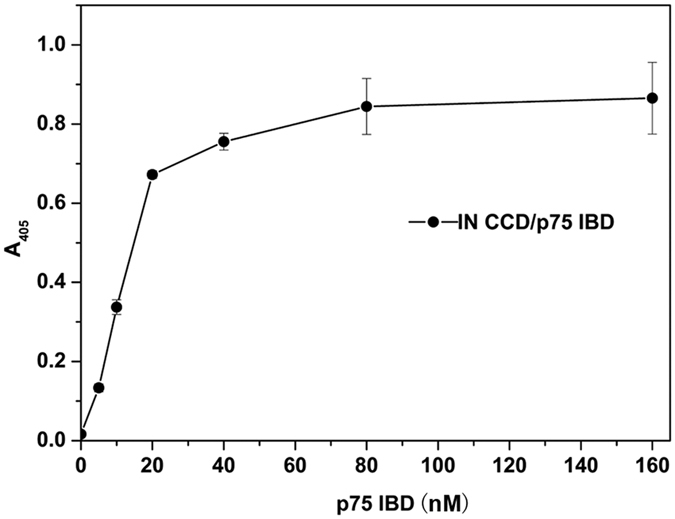
Determination of the optimal IN CCD and LEDGF/p75 IBD ratio and protein concentrations for the assay.The assay signal was measured using a fixed concentration of IN CCD (20 nM) against a titration of LEDGF/p75 IBD. Signal was obtained as A405. Error bars represent SD from 3 replicate values. A ratio of 1:1 IN CCD : LEDGF/p75 IBD was chosen for the subsequent assays.